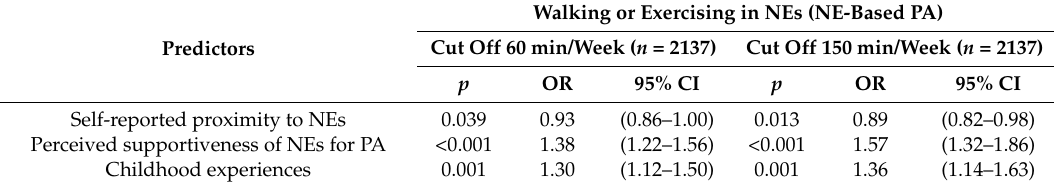
Table 2. Logistic regression of self-reported proximity to NEs, perceived supportiveness of natural environment for physical activity and childhood experiences predicting different levels of physical activity in Norwegian adults, controlling for socio-demographic